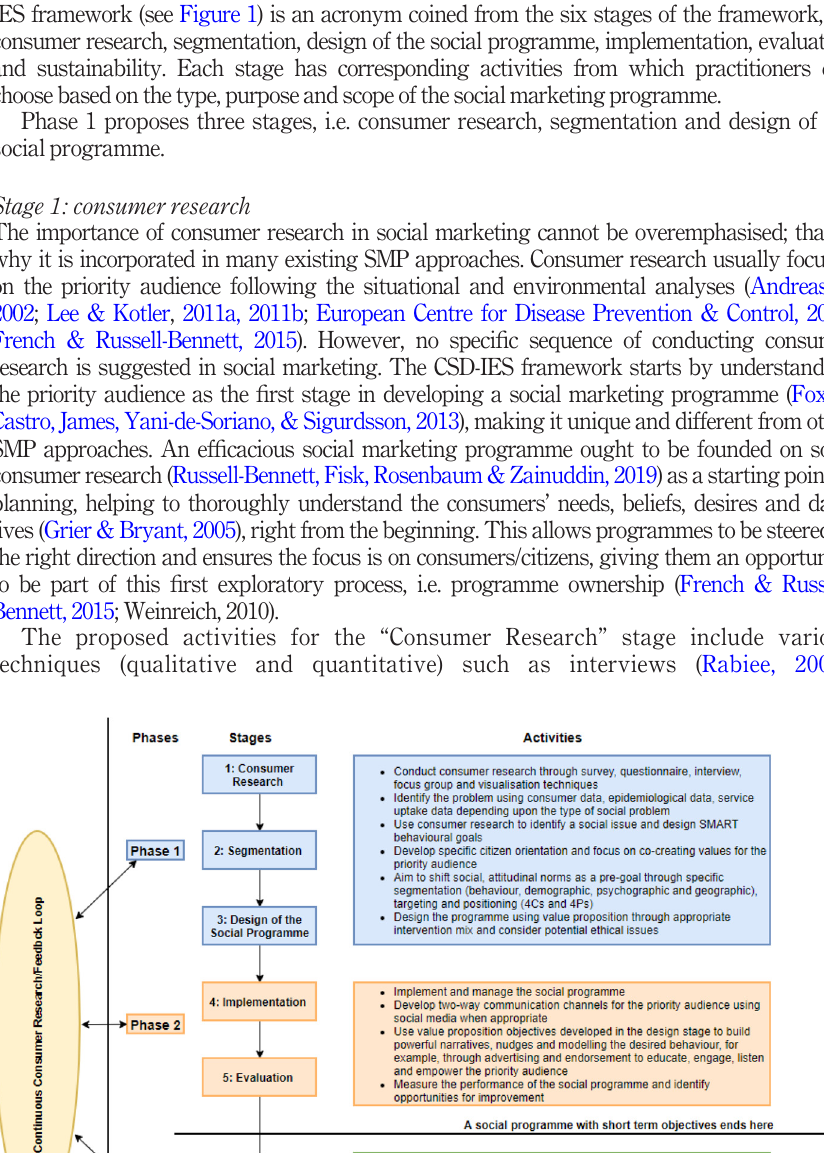
Figure 1. CSD-IES